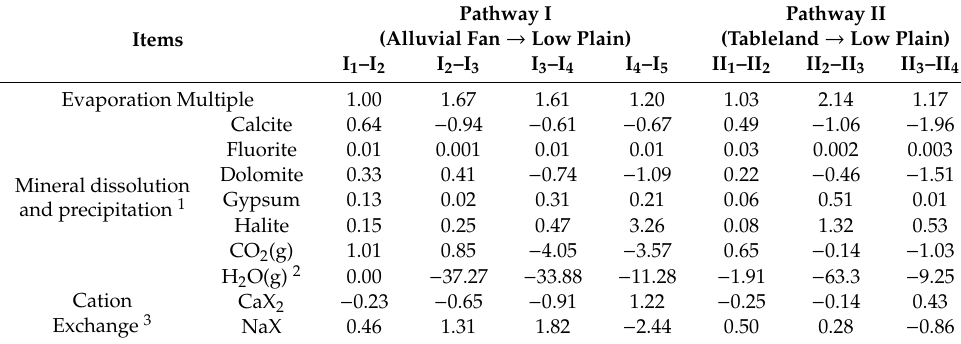
Table 2. The result of hydrogeochemical